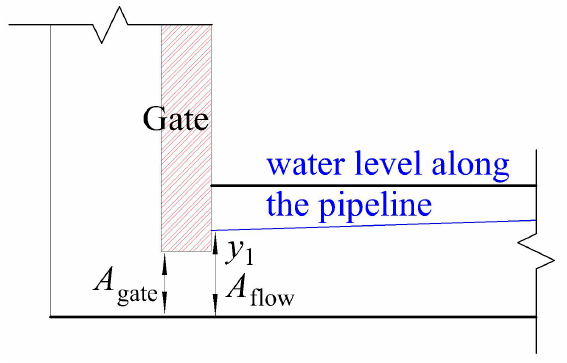
Figure 10. Details of upstream boundary parameters.